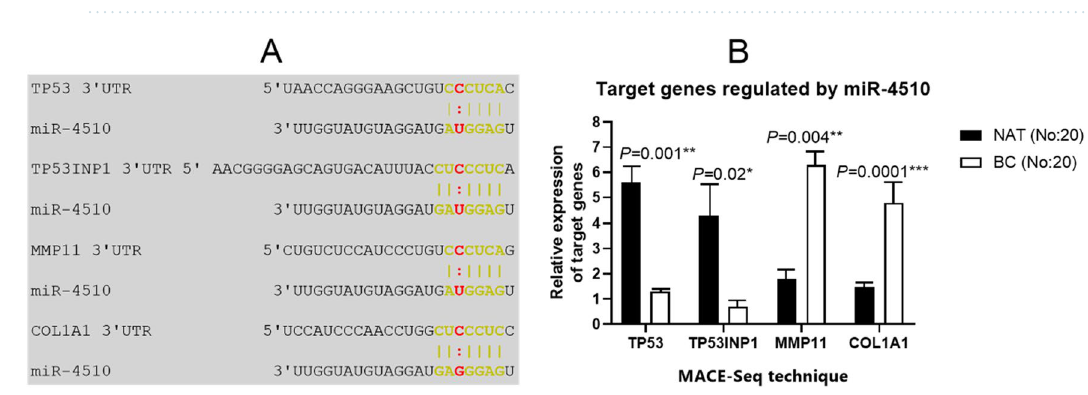
Figure 3. A schematic depiction of miR-4510 gene locus. Tracks represent the chromosomal regions, miR-4510 gene, SNP positions, and most predominant RefSeq. Comparison of mature sequences of miR-4510 in BC, and NAT with the Reference Sequence (RefSeq). Guanin (G) was changed into Thymine (T) in BC and NAT and Guanin (G) inside the seed sequence was also changed into Adenine (A) in BC compared to the RefSeq.